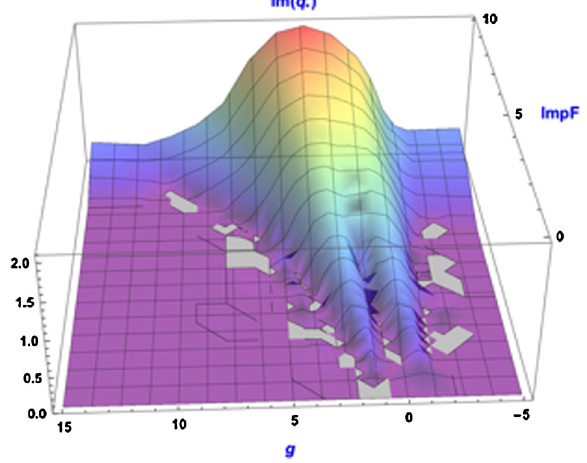
FIG. 13. Same, for a larger range of the